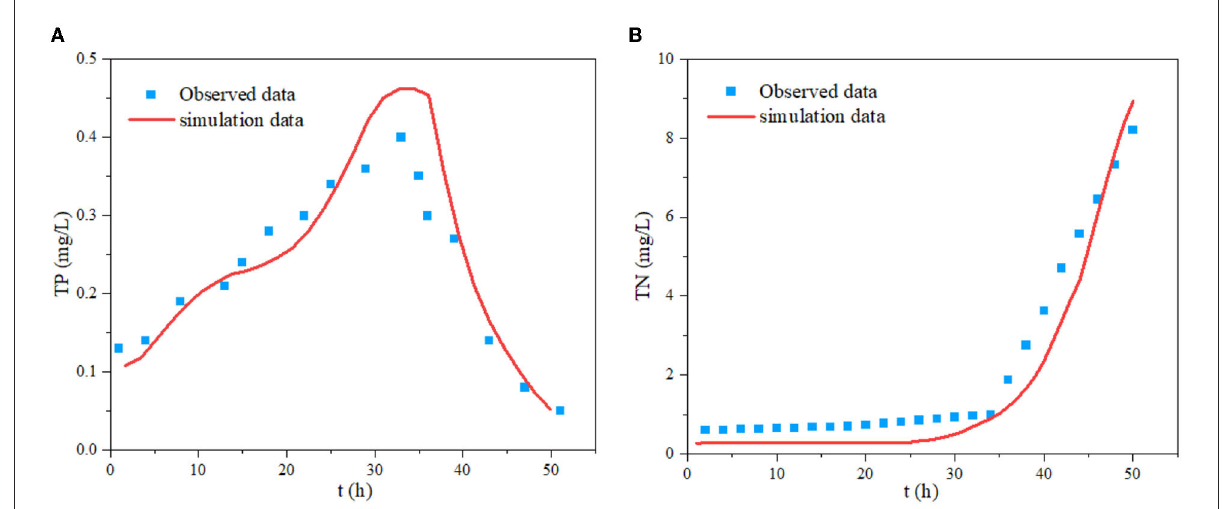
FIGURE12 Comparisons of the simulation and observed results: (A) TP; (B)